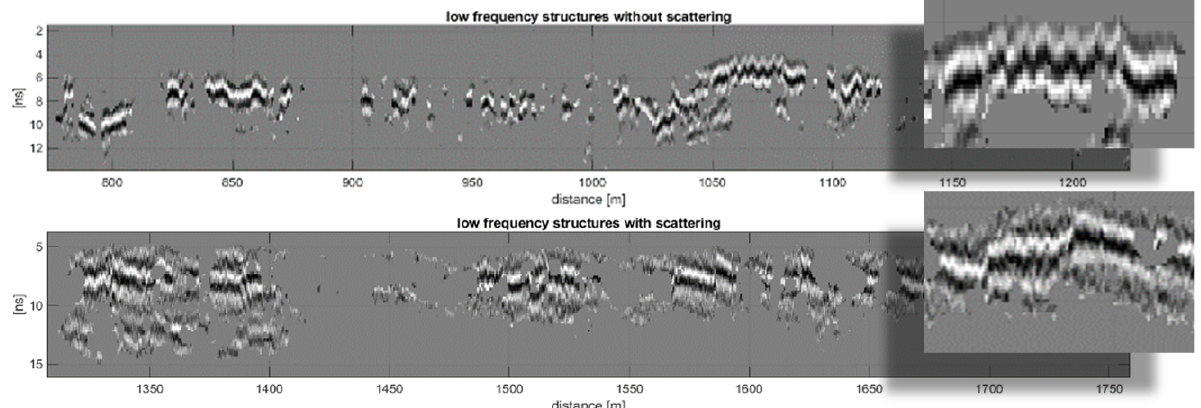
Figure 7. Upper : typical low-frequency structures without local scattering; lower : low-frequency structures with strong local scattering, which manifests as an overlaid noise-like pattern.